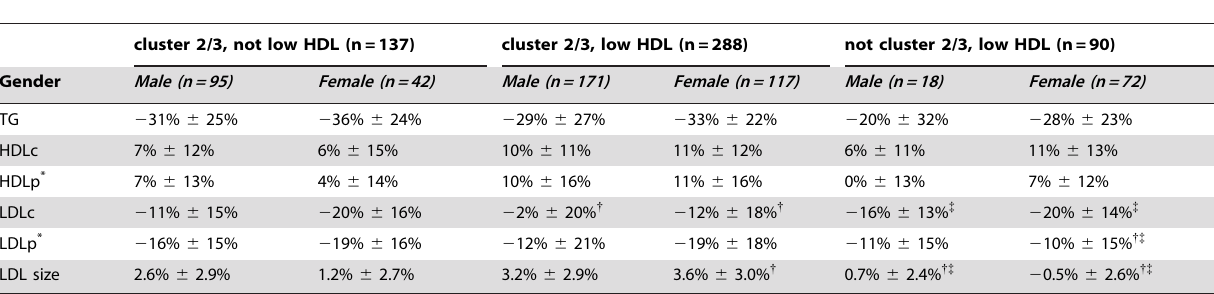
Table 3. Percent changes after fenofibrate intervention in low HDLc subgroup versus subjects in lipoprotein clusters 2 and